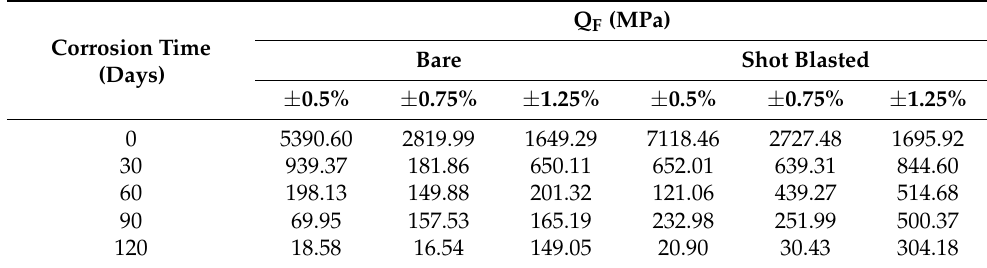
Table 10. Values of fatigue damage indicator Q F on bare and shot blasted specimens (in non-corroded and corroded